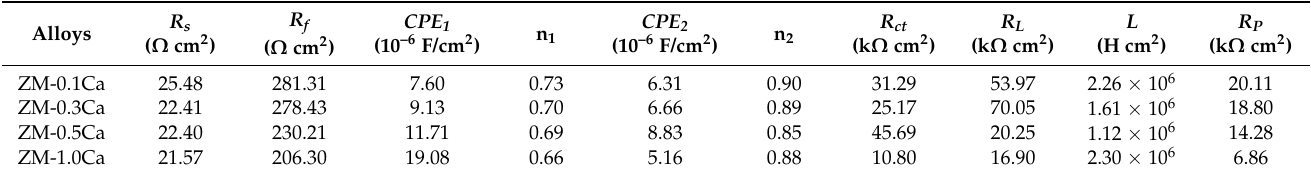
Table 4. The fitting results of the EIS spectra of ZM-xCa alloys.